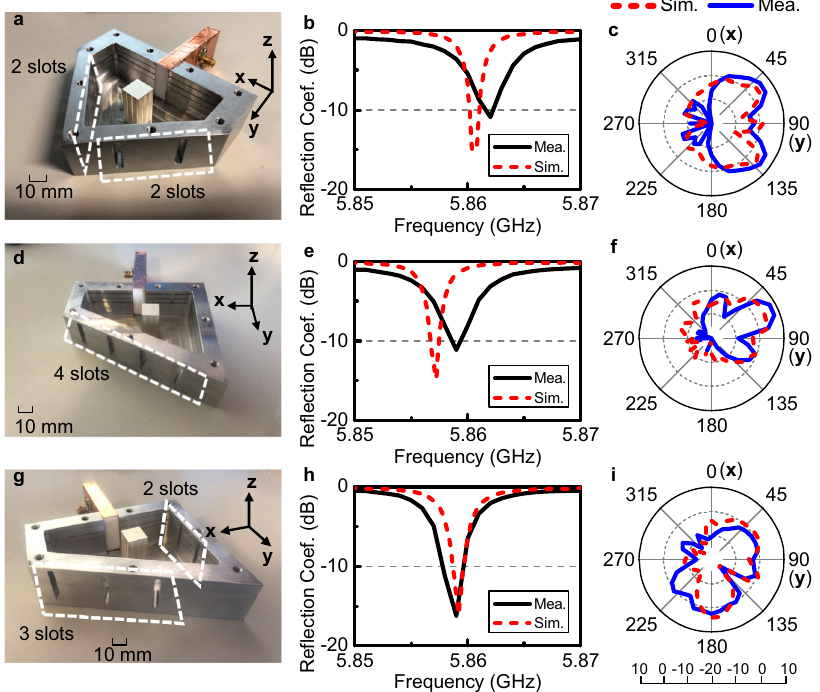
Fig. 3 Experimental demonstrations of geometry-independent ENZ-based antennas. a Photograph of Antenna 1 where the metallic cover is not installed yet. b Simulated and measured re fl ection coef fi cients of Ant. 1. c The simulated and measured angular distributions of radiated fi elds of Ant. 1 in the E-plane which is parallel to the electric fi eld. d Photograph of Antenna 2 where the metallic cover is not installed yet. e Simulated and measured re fl ection coef fi cients of Ant. 2. f The simulated and measured angular distributions of radiated fi elds of Ant. 2 in the E-plane which is parallel to the electric fi eld. g Photograph of Antenna 3 where the metallic cover is not installed yet. h Simulated and measured re fl ection coef fi cients of Ant. 3. i The simulated and measured angular distributions of radiated fi elds of Ant. 3 in the E-plane which is parallel to the electric fi eld.